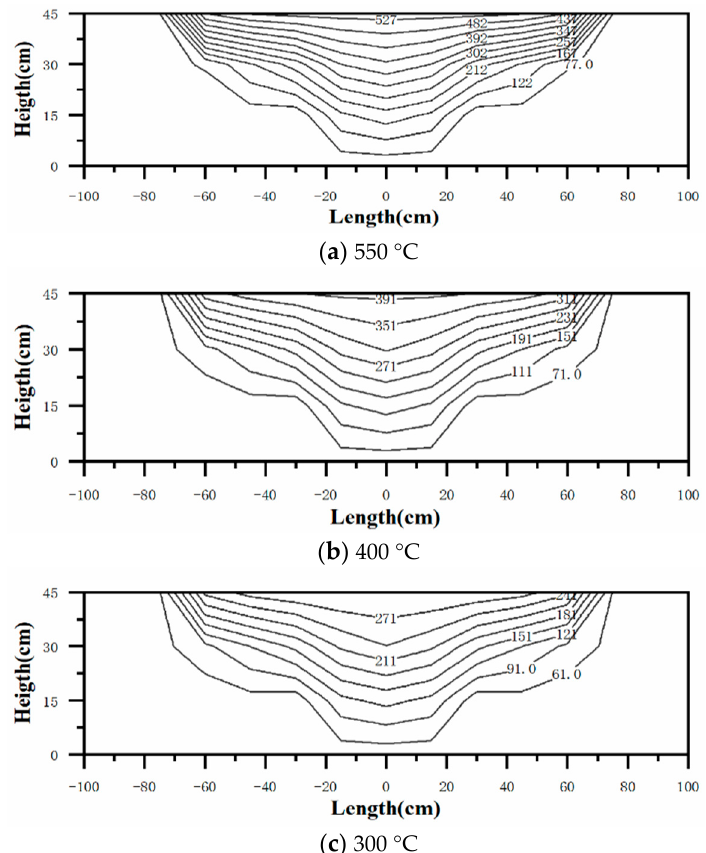
Figure 10. The temperature distribution of the insulation foundation.